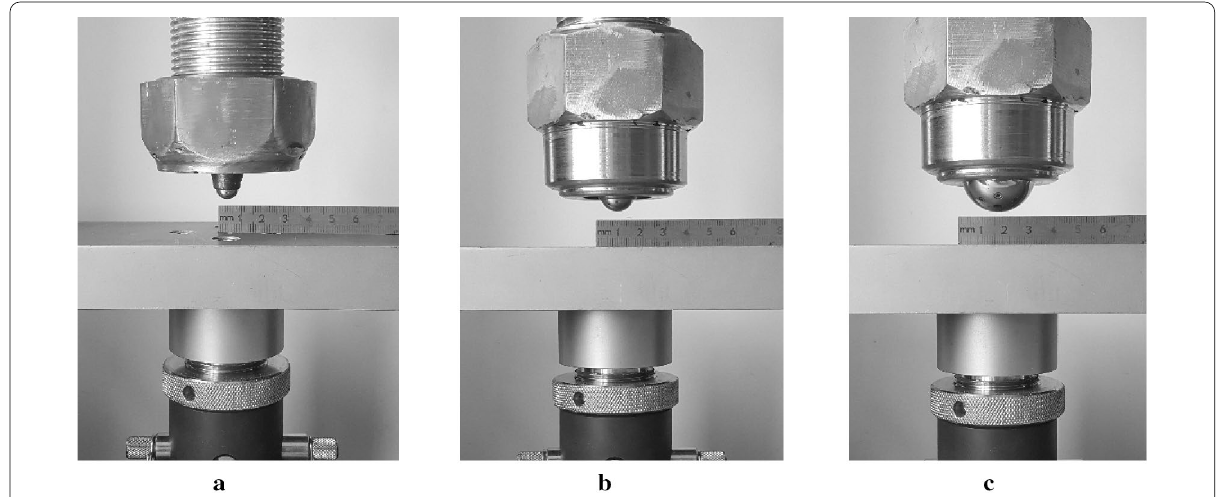
Fig. 3 Ball indenters with diameters, respectively: a 10 mm, b 15 mm, c 30